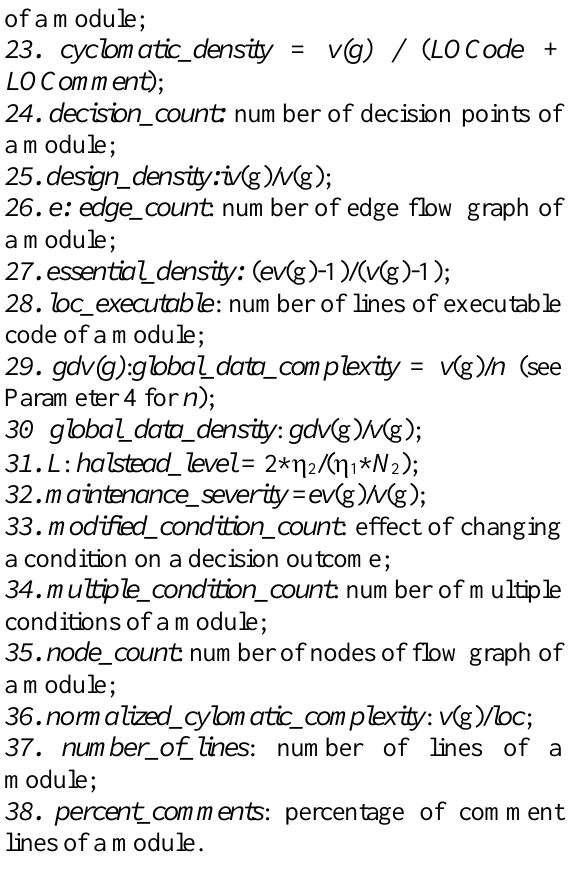
Table 2. Metrics selection using CFS method for original and sampled data. Selected metrics of original Dataset data